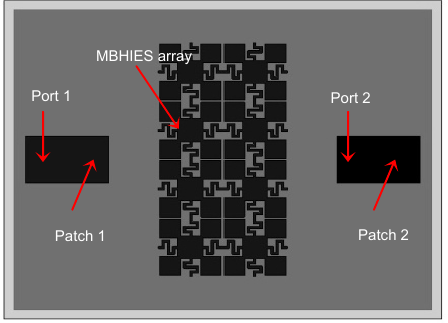
Figure 6. E-plane coupled microstrip antenna array with